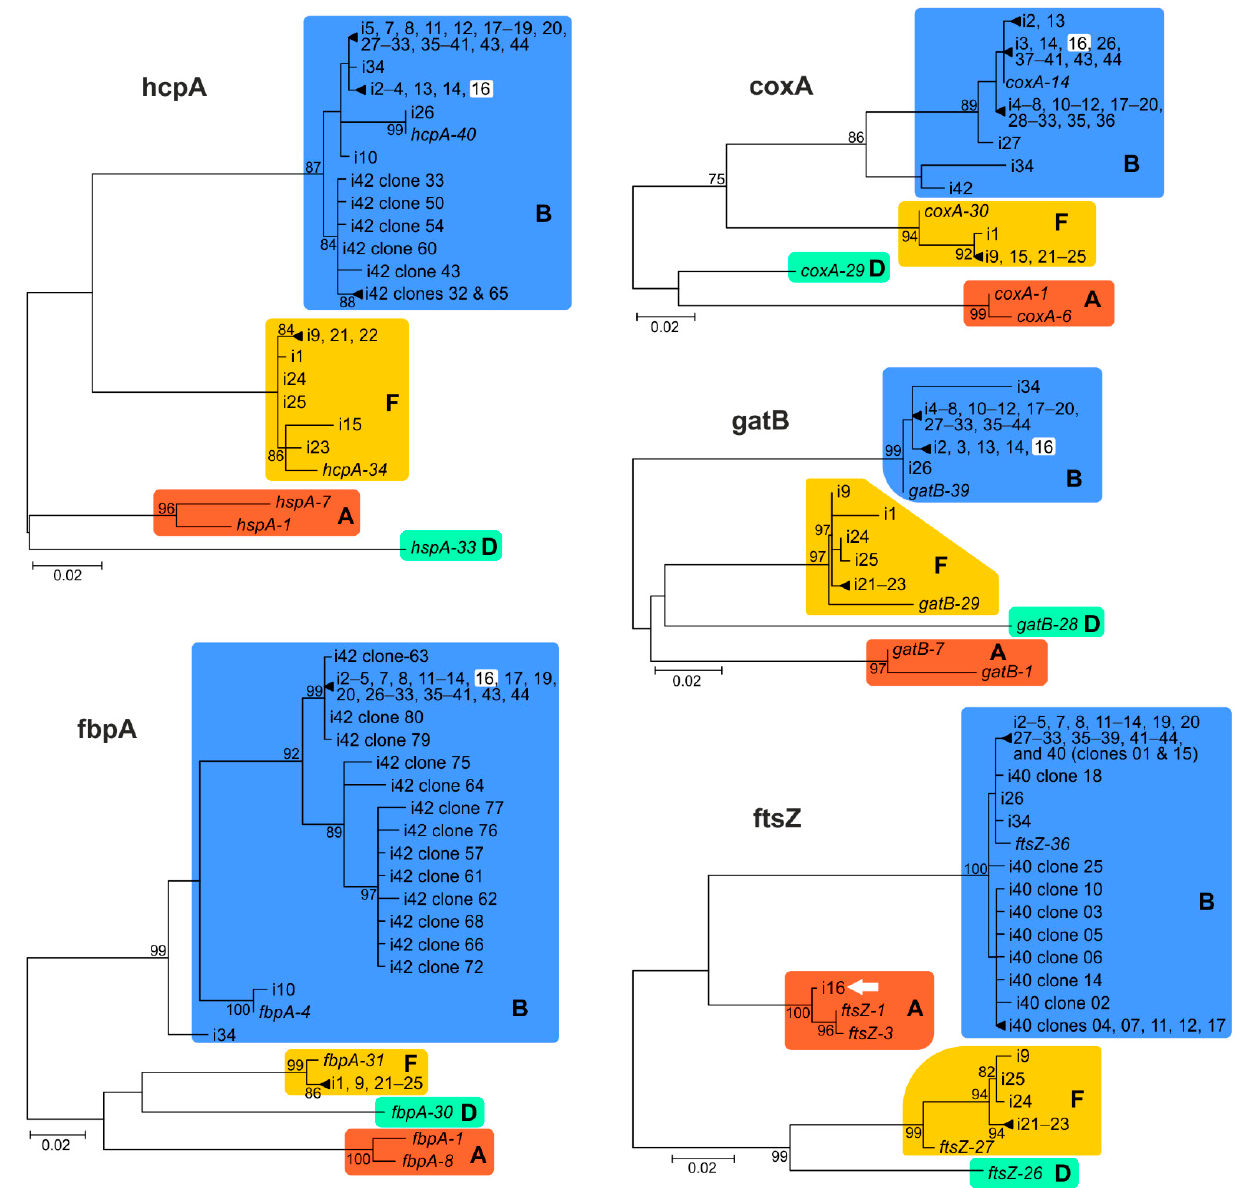
Figure 1. Maximum likelihood (ML) phylogenetic trees for each MLST gene. Acrididae isolates (Table 2), supergroups (A, B, F, and D), and bootstrap values are indicated. Model of nucleotide substitutions T92+G was used for gatB , hcpA , and fbpA datasets; HKY+G for coxA ; T92+G for ftsZ . White squares and the arrow indicate a case (i-16) of a supergroup clustering conflict. See original files in Supplementary Materials.